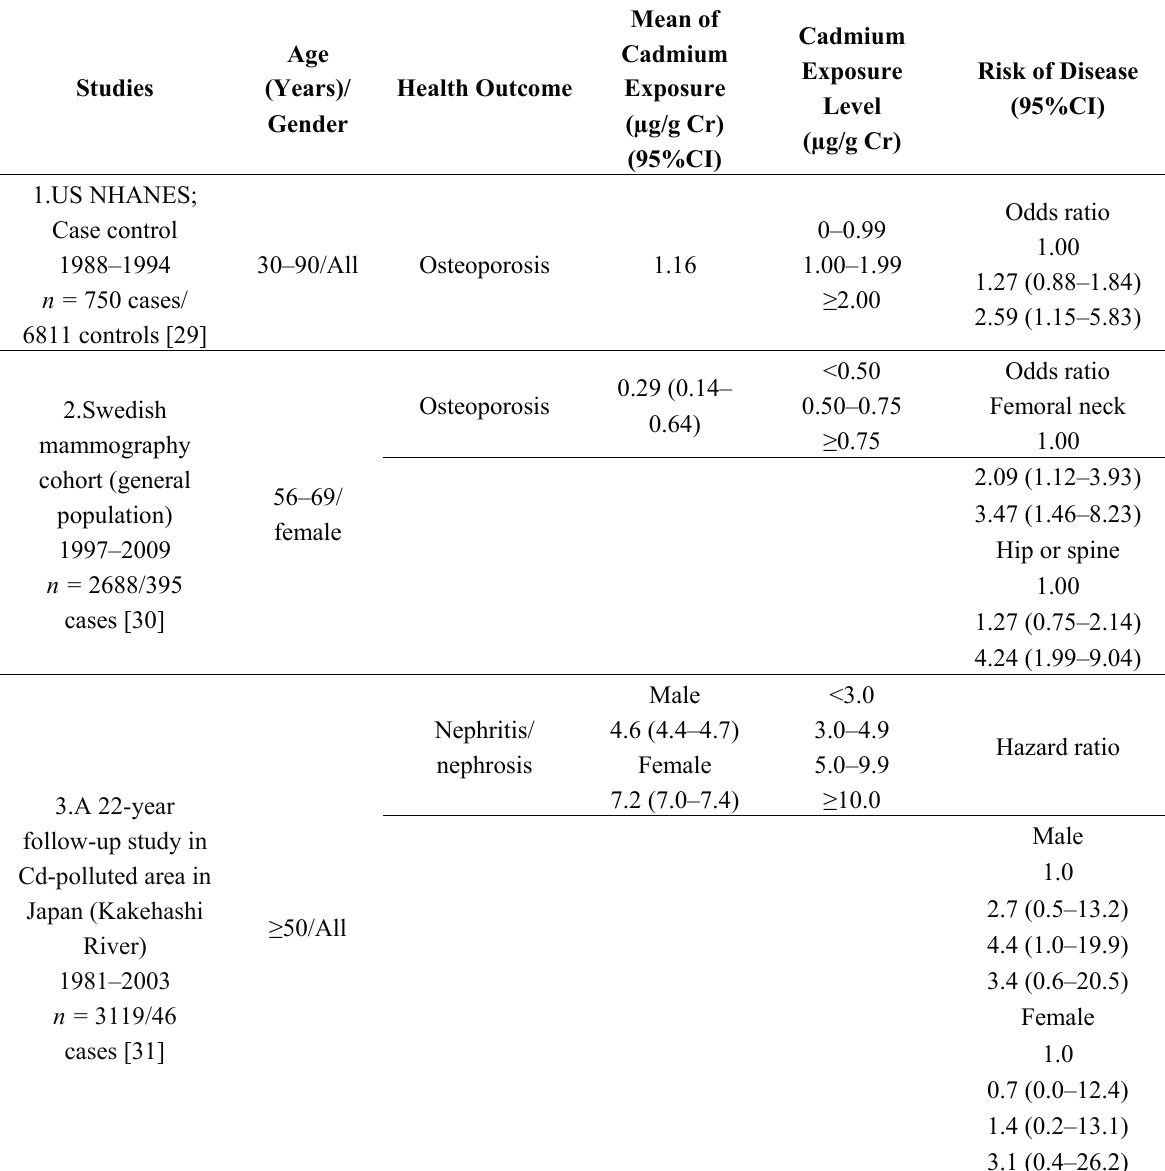
Table 1. Selected studies with U-Cd level and risk of health outcomes for population attributable fraction (PAF) estimation in the Mae Sot